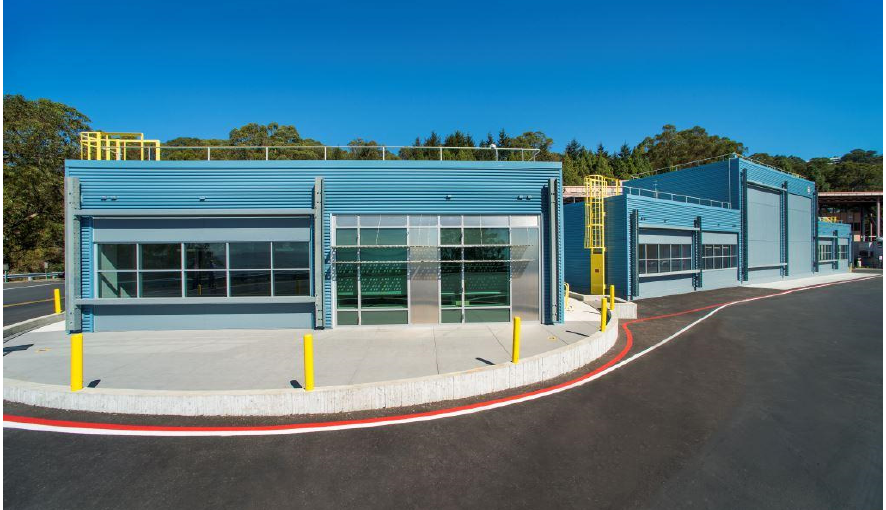
Figure 1. FLEXLAB test facility; with the rotating testbed shown at center.